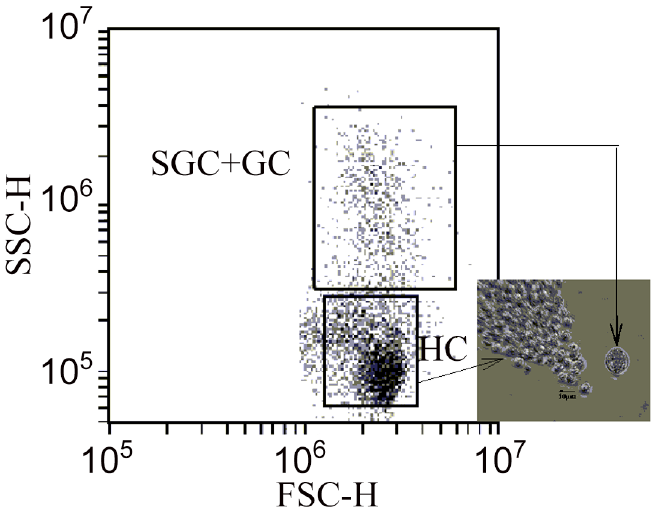
Fig 1. Forward Scatter (FSC-H) versus Side Scatter (SSC-H) of hemolymph from Chionoecetes bairdi , Tanner Crab.